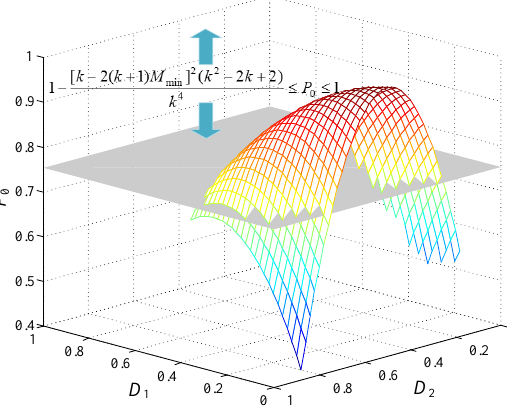
Figure 10. Feasible region of M I1 with k = 1.5, M = 0.1, D 3 =